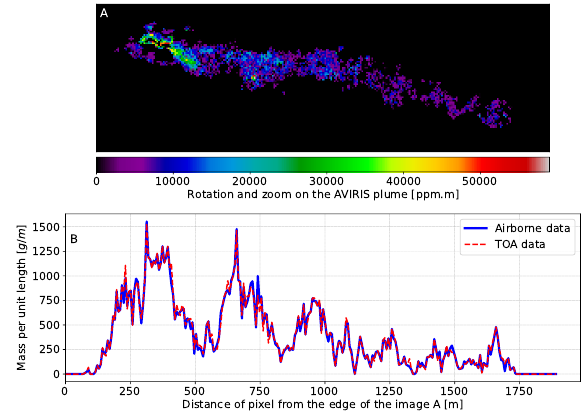
Figure 8. A : Concentration map zoom on the plume (in ppm.m) for TOA image. B : Mass per unit length (in g/m) along the plume (in m) for airborne data, in blue, and for translation to TOA data, in red.